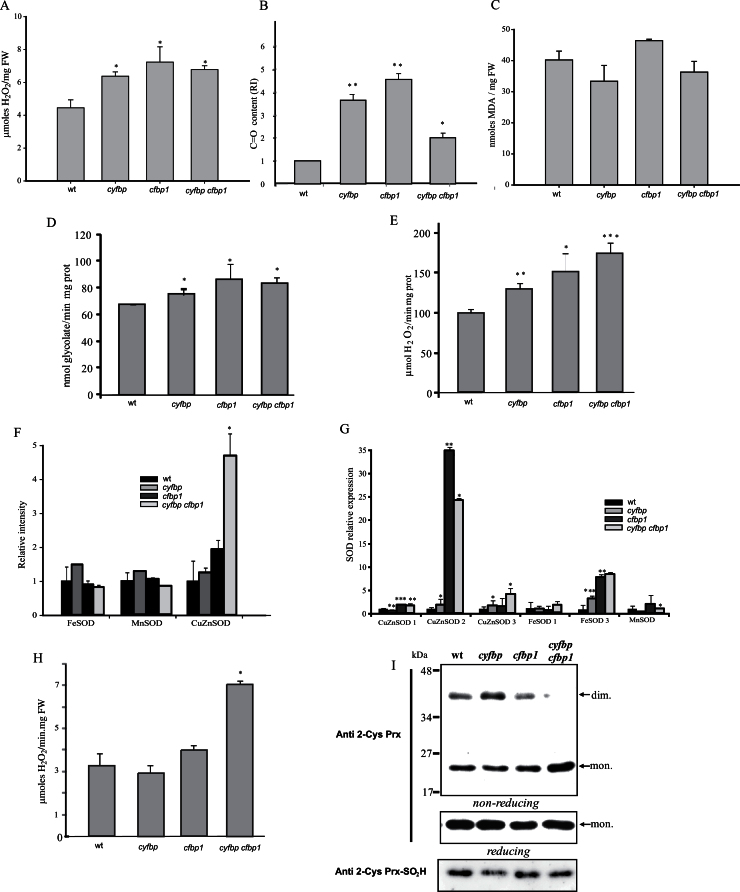
Reactive oxygen species metabolism in the Arabidopsis wild type (wt) and cyfbp, cfbp1, and cyfbp cfbp1 mutants. (A) Determination of H2O2 by fluorometry. (B) Protein oxidation measured as carbonyl group content. (C) Lipid peroxidation measured as malondialdehyde (MDA) content. (D) Glycolate oxidase (GOX) activity. (E) Catalase (CAT) activity. (F) Relative intensity of MnSOD, FeSOD, and CuZnSOD activities quantified by the Bio-Rad software Quantity one. (G) Analysis of mRNA SOD expression by qRT–PCR. (H) Ascorbate peroxidase (APX) activity. (I) Western blot analysis using anti-2-Cys Prx and anti 2-Cys Prx-SO2H antibodies. Each bar represents the mean ± SE of three independent experiments. Differences between mutant plants and the wt were significant at *P<0.05, **P<0.01, and ***P<0.001.